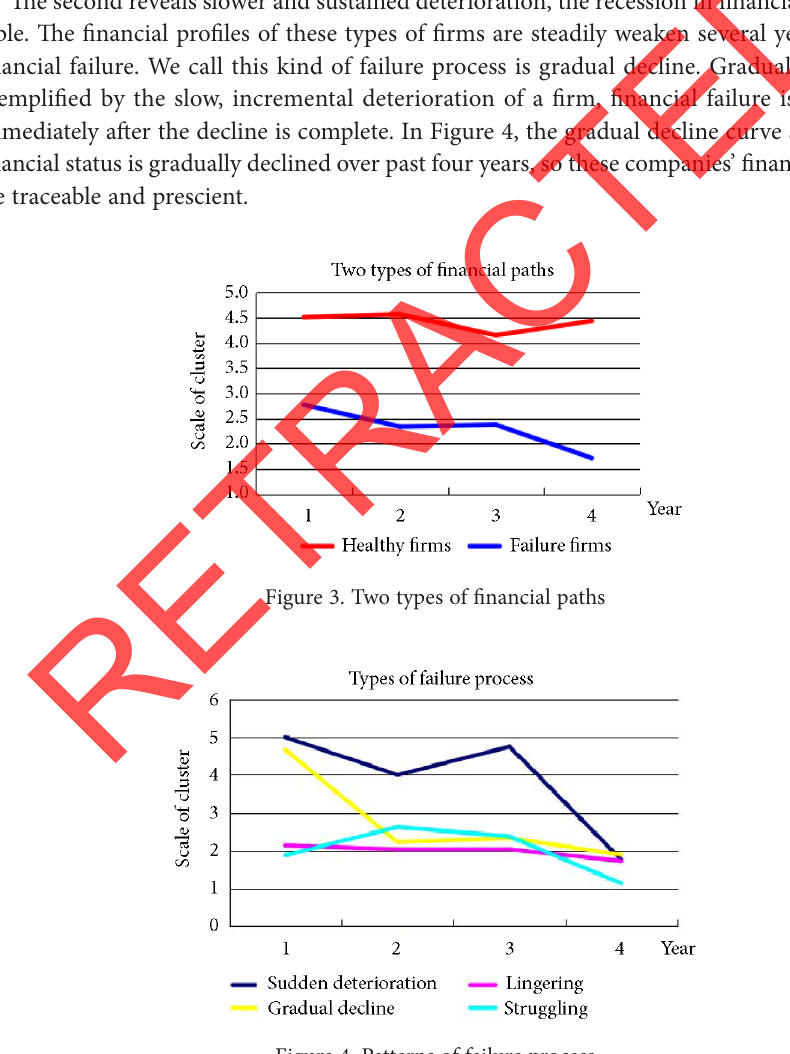
Figure 4. Patterns of failure